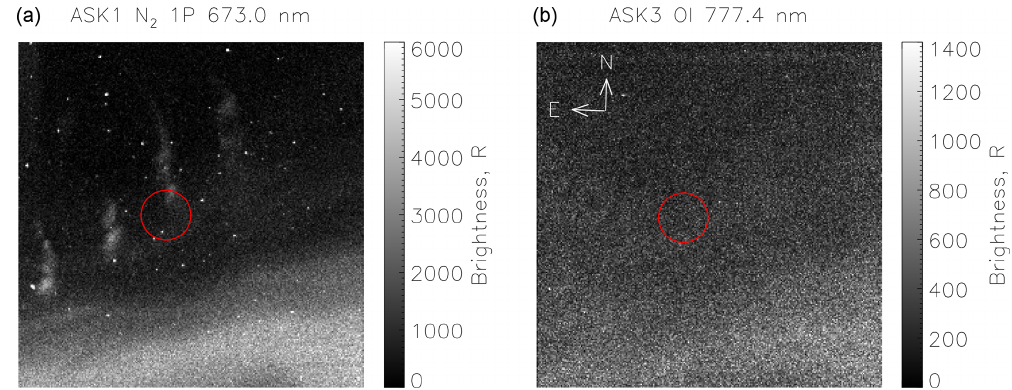
Figure 2. Simultaneous images in N 2 1P ( a ; ASK1) and OI 777.4nm ( b ; ASK3) at 19:04:15.438UT during event 1. The FAEs are visible in N 2 1P, whereas only the auroral arc is visible in OI 777.4nm across the bottom right of the image. The full width at half maximum of the ESR beam is shown as a red circle in both